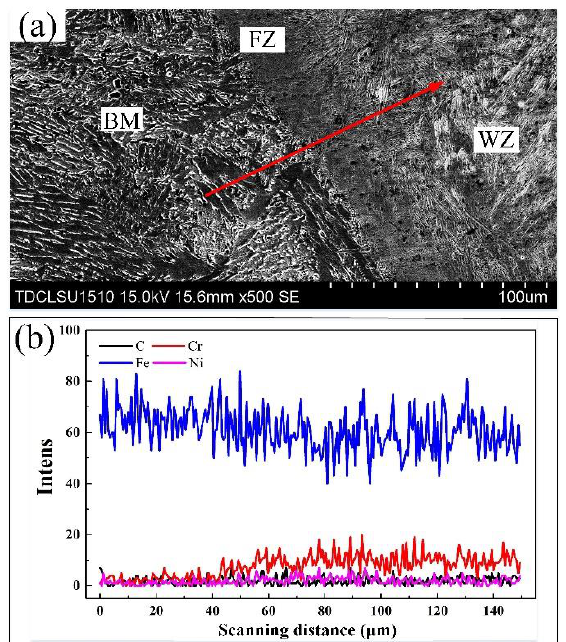
Figure 12. EDS line scan across the weldment. ( a ) Schematic diagram of the weld zone; ( b ) alloying elements’ line scanning.